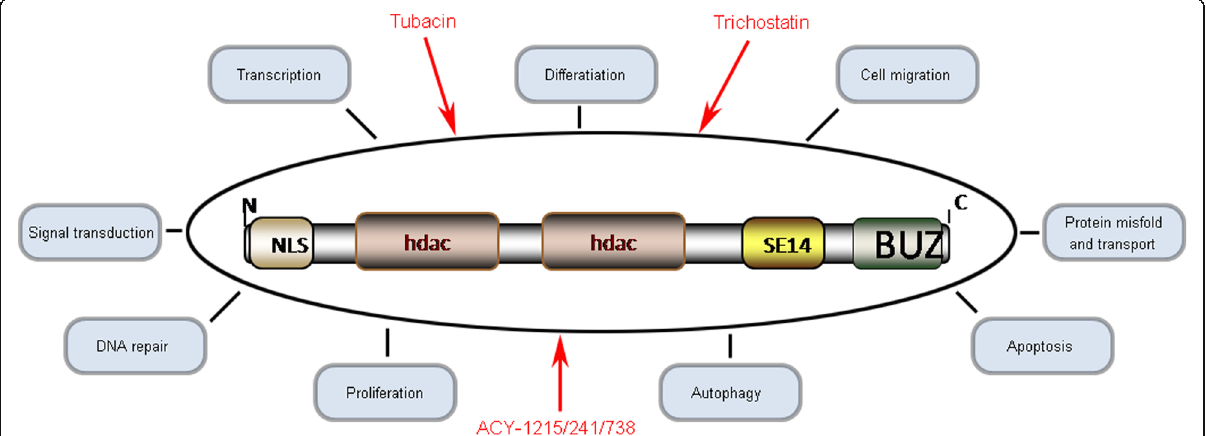
Fig. 1 Schematic diagram of the structure and pleiotropic functions of HDAC6